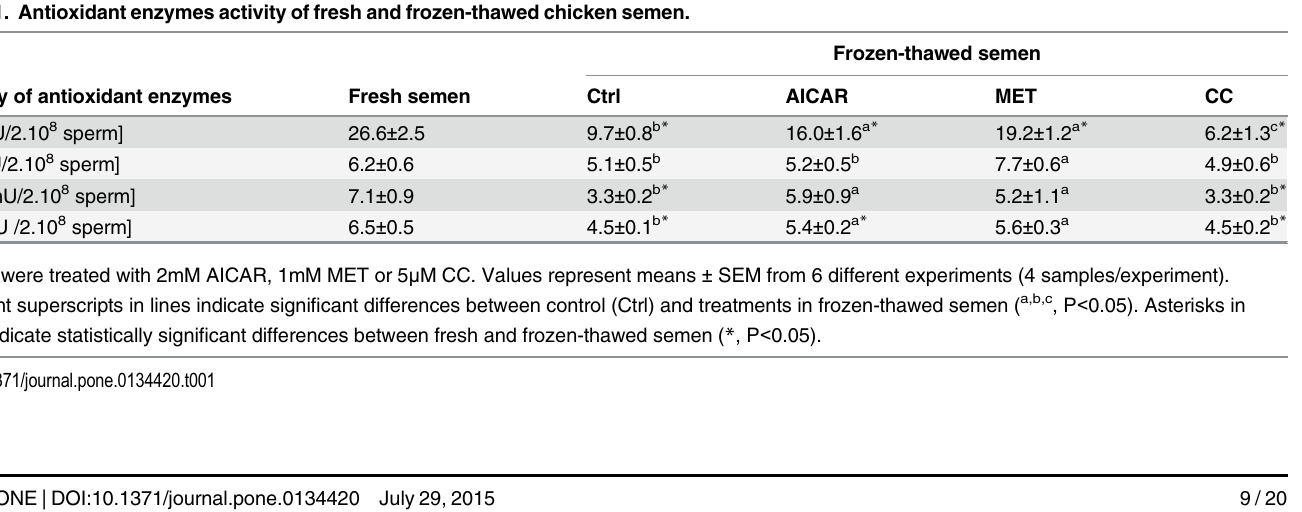
Frozen-thawed semen